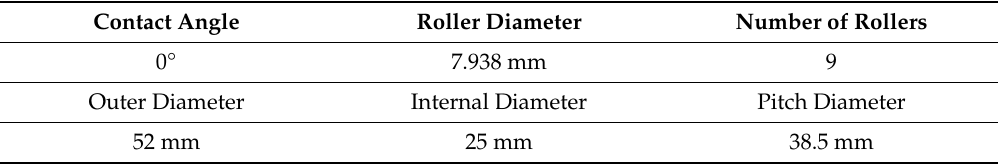
Figure 7. The real pictures of four bearings with four different health conditions. Table 2. Specifications of the test bearings.